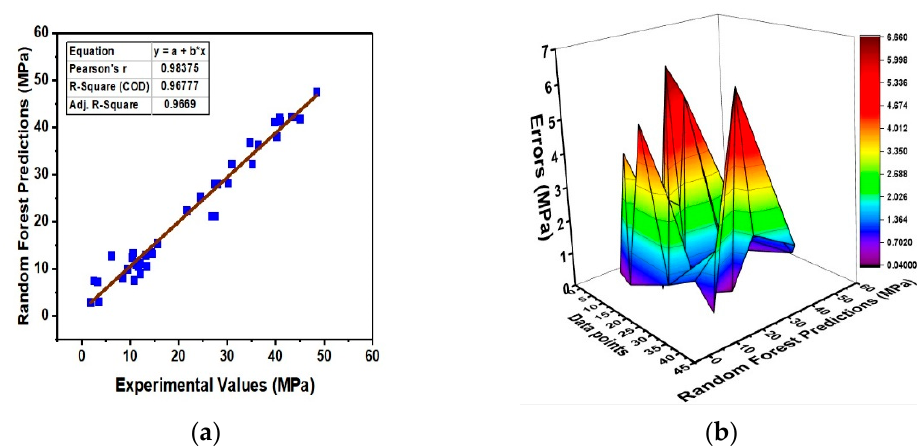
Figure 5. Results of random forest ML approach; ( a ) regression relation between experimental and prediction values; ( b ) Prediction errors distribution. prediction values; ( b ) Prediction errors